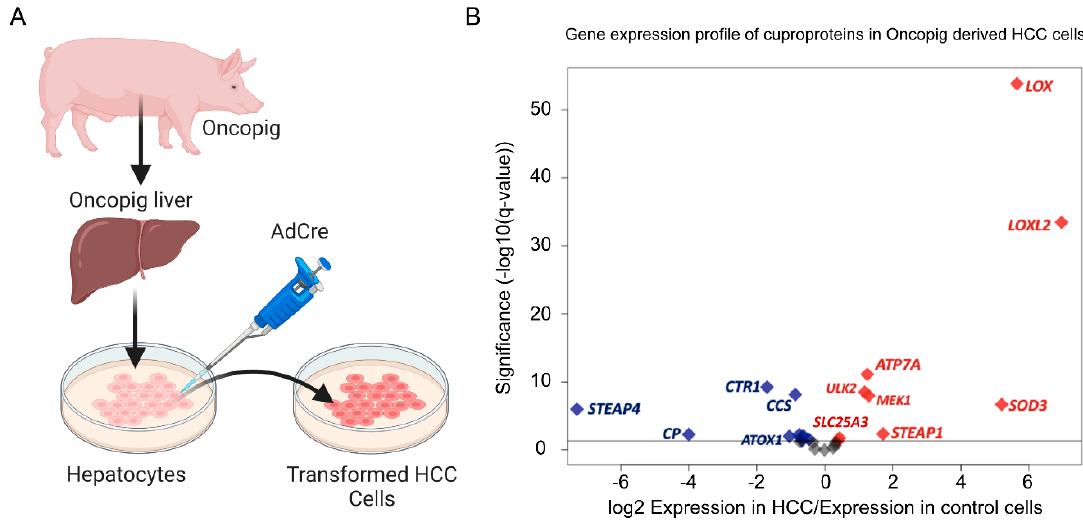
Figure 4. Differential expression of Cu-related genes in Oncopig-derived HCC cells. ( A ) Process to obtain Oncopig HCC cell lines. ( B ) Volcano plot of genes encoding for cuproproteins in Oncopig HCC cells plotting magnitude expression difference by significance. The horizontal line represents q-value = 0.05. Red indicates significant upregulation, blue denotes significant downregulation, and grey represents non-significant changes in expression. HCC Accession codes: The datasets are available in the European Nucleotide Archive accession number: PRJEB8646. Figure created in BioRender.com and R software (version 4.0.3) [125].